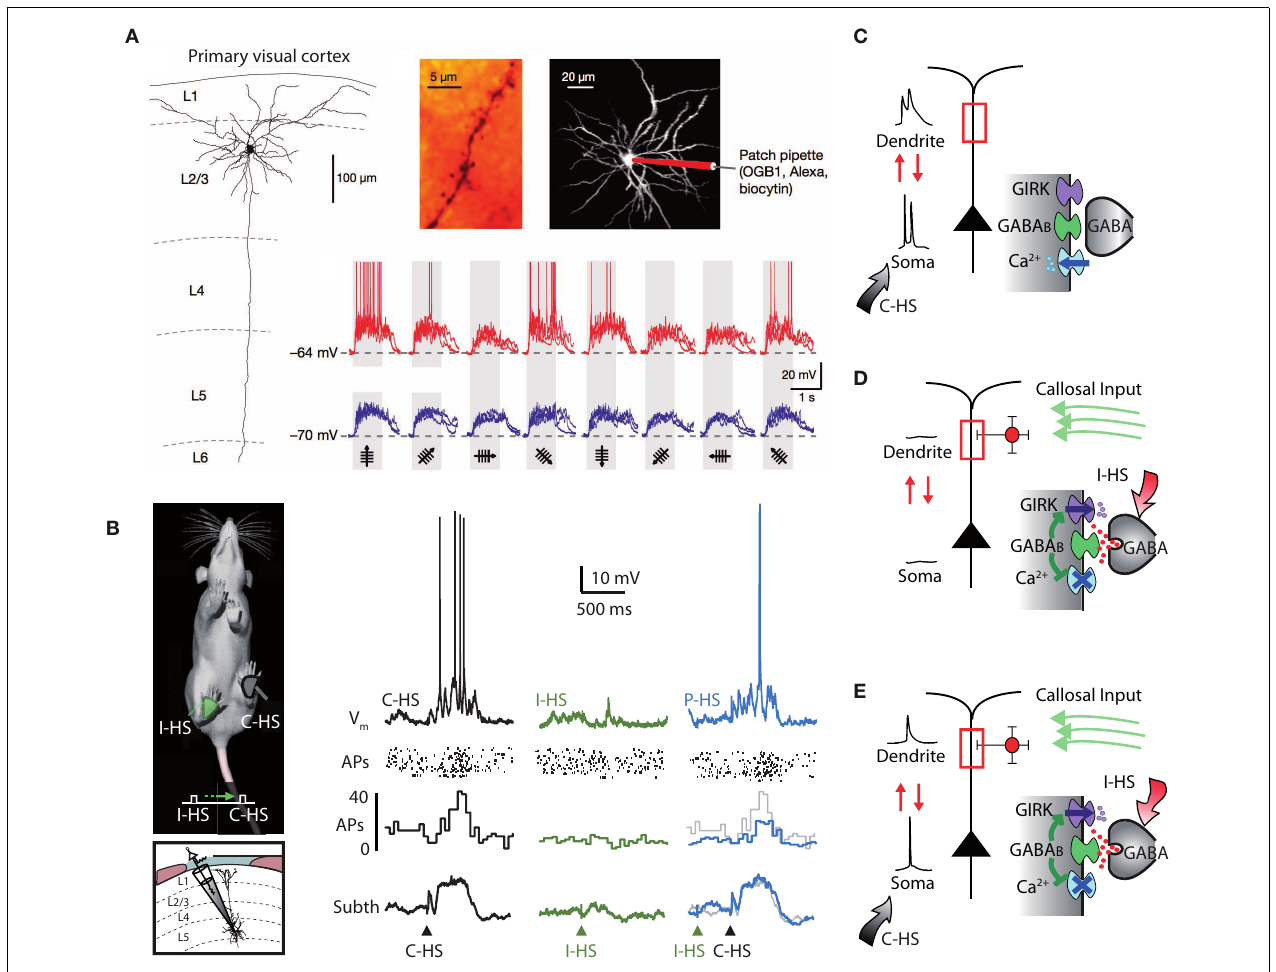
difference was due to a form of dendritic GABA B -mediated silent inhibition. This comes about because the inhibitory action is predominately on voltage-sensitive dendritic conductances.Without dendritic inhibition, AP firing in the neuron activates dendritic conductances which contribute to the integrative process in the production of subsequently generated APs. (D) Dendritic inhibition in the absence of cell firing opens dendritic K + channels which have a very weak influence on the soma but their blocking action on dendritic Ca 2 + channels is hidden or silent because these channels are closed anyway in the absence of dendritic depolarization. (E) Only during cell firing can the absence of the contribution from dendritic conductances be observed. Adapted from (Palmer et al.,